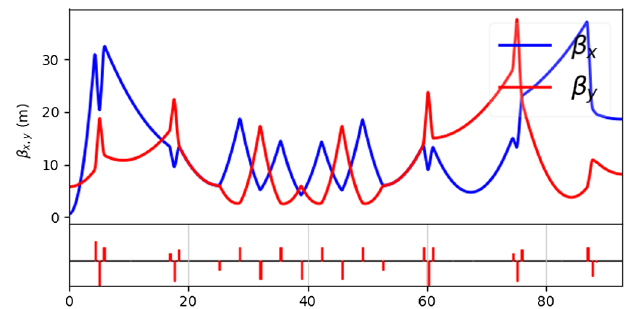
FIG. 3. Optical functions in a cell of the arc (octant) without the undulator insertions.